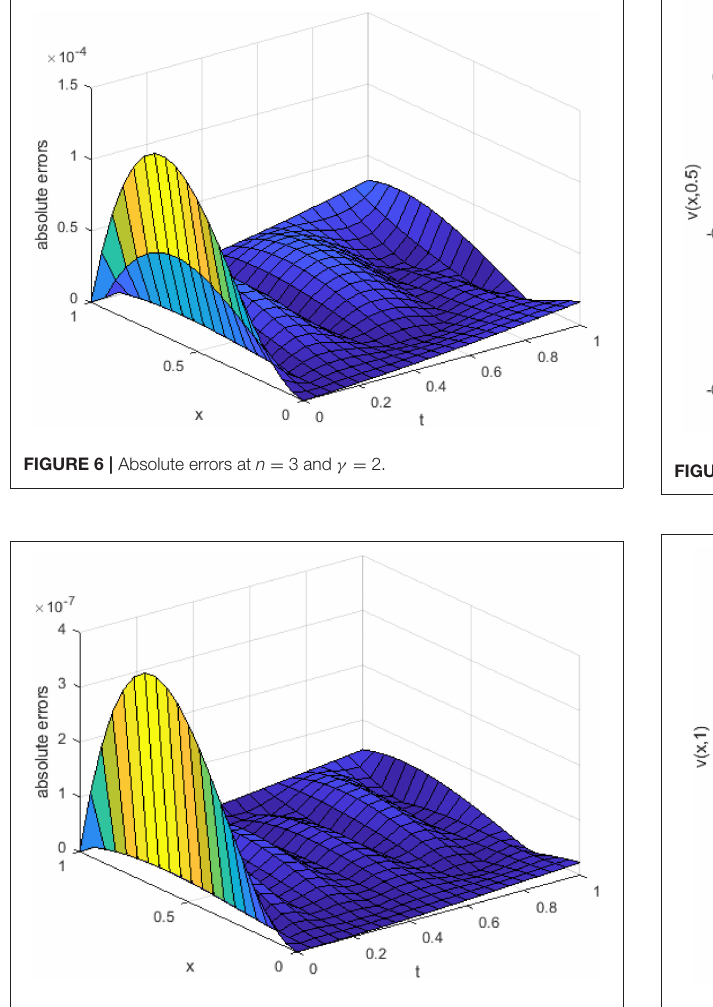
FIGURE 10 | Approximate solution at different values of x and γ at t =